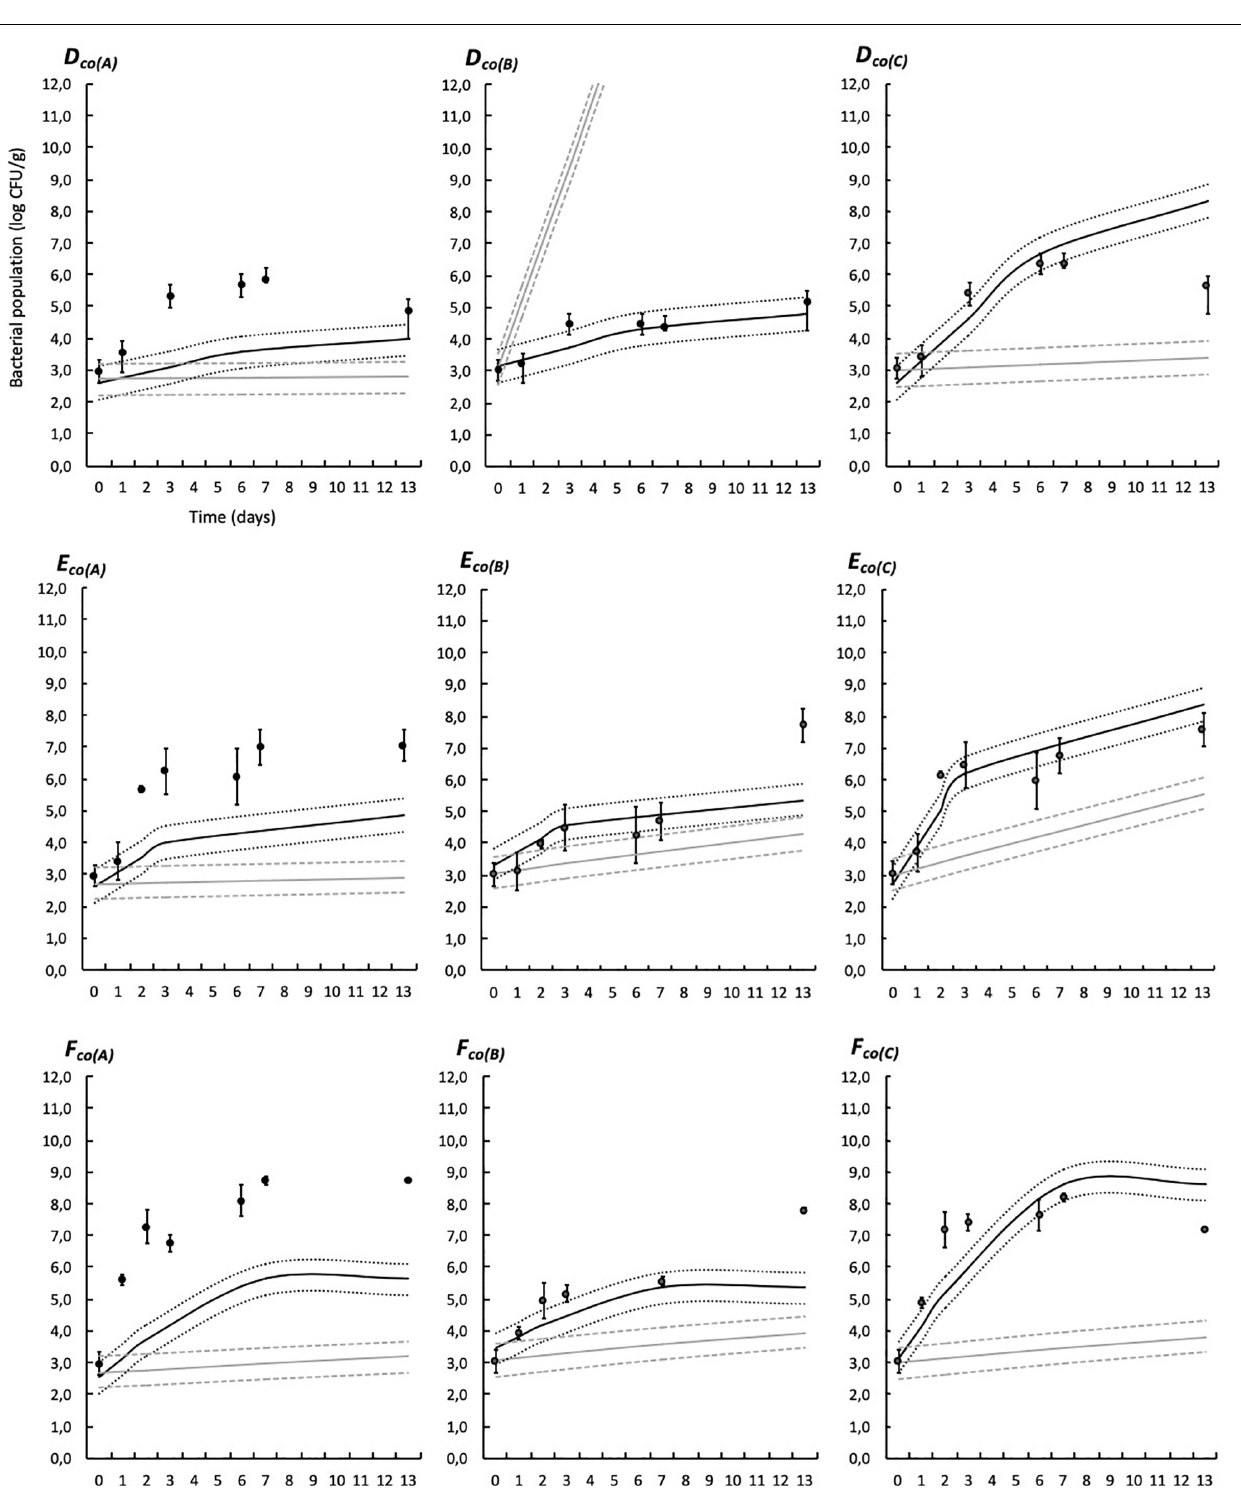
Frontiers in Microbiology |